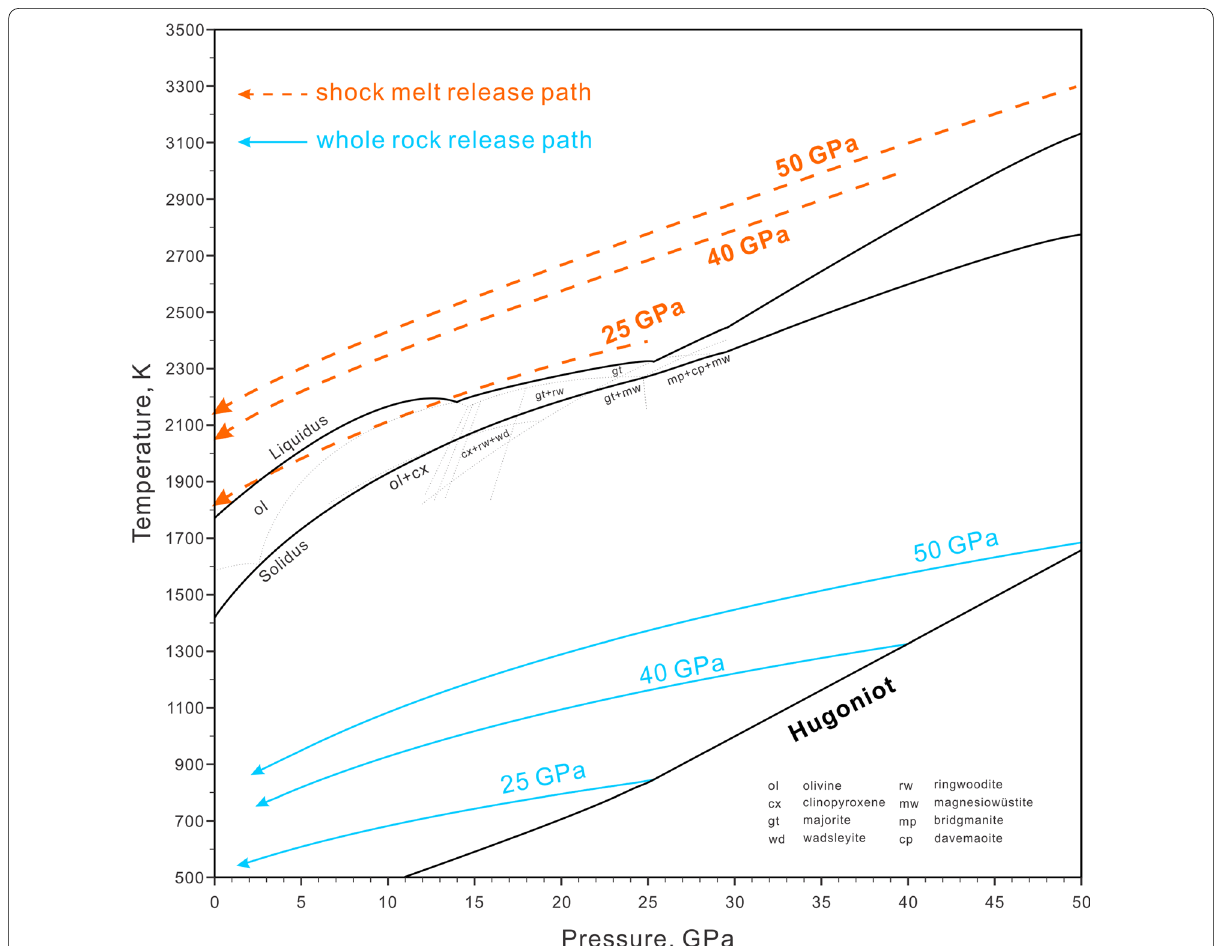
Fig. 5 The adiabatic release paths of L chondrite bulk rock (cyan) and shock melt (orange) at 25, 40 and 50 GPa superimposed on the phase diagram of Agee et al. (1995). The P–T Hugoniot of L chondrite is the same as Figs. 2 and 3. The calculation parameters are in Tables 1 and